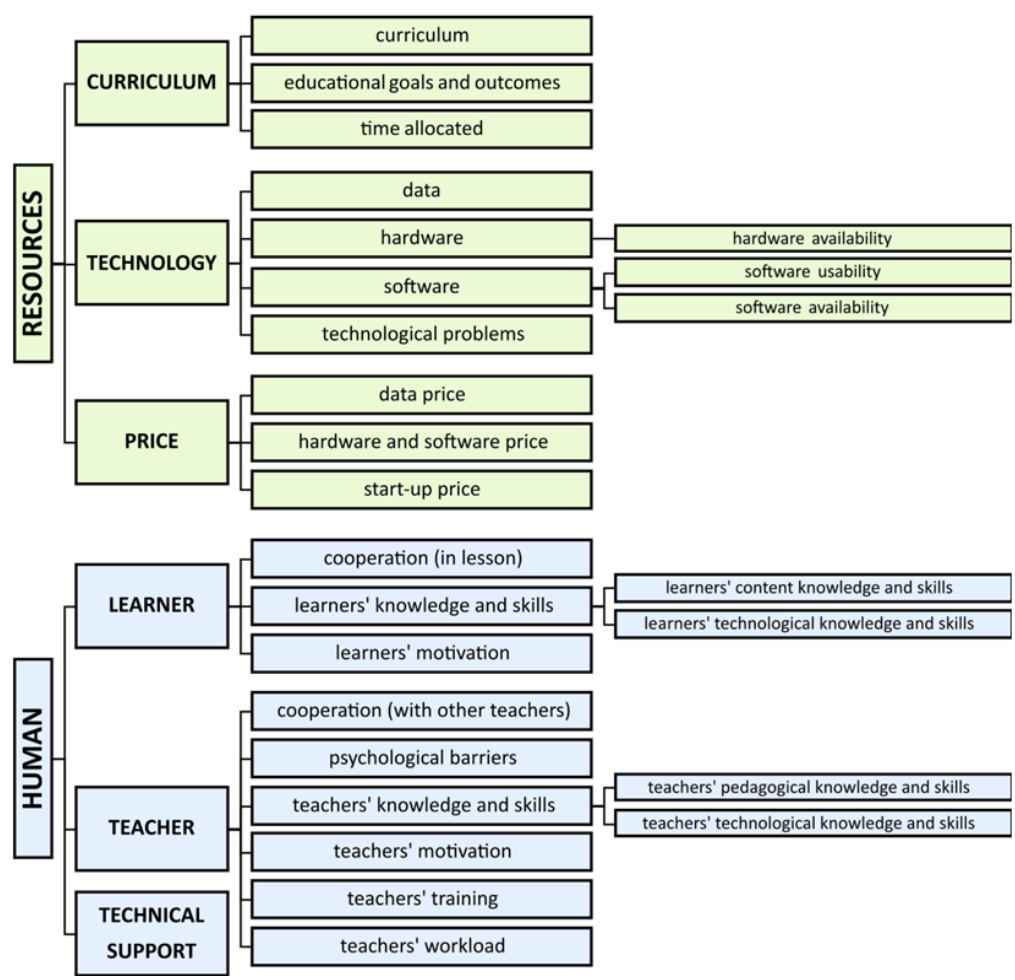
Figure 5. The categorisation of the limits of GIS implementation in education.